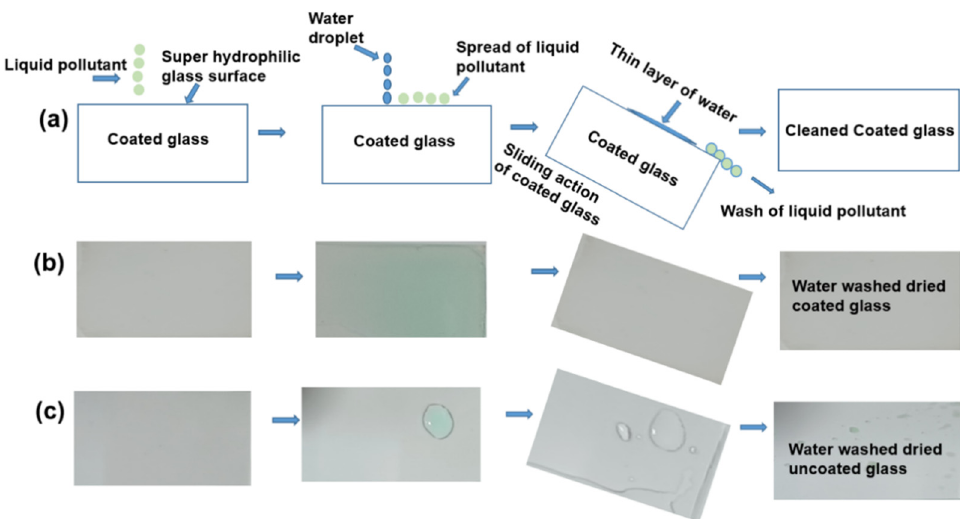
Figure 7. Schematic design of ( a ) self-cleaning mechanism of super-hydrophilic glass substrate, and self-cleaning behaviors of ( b ) coated glass and ( c ) bare glass.